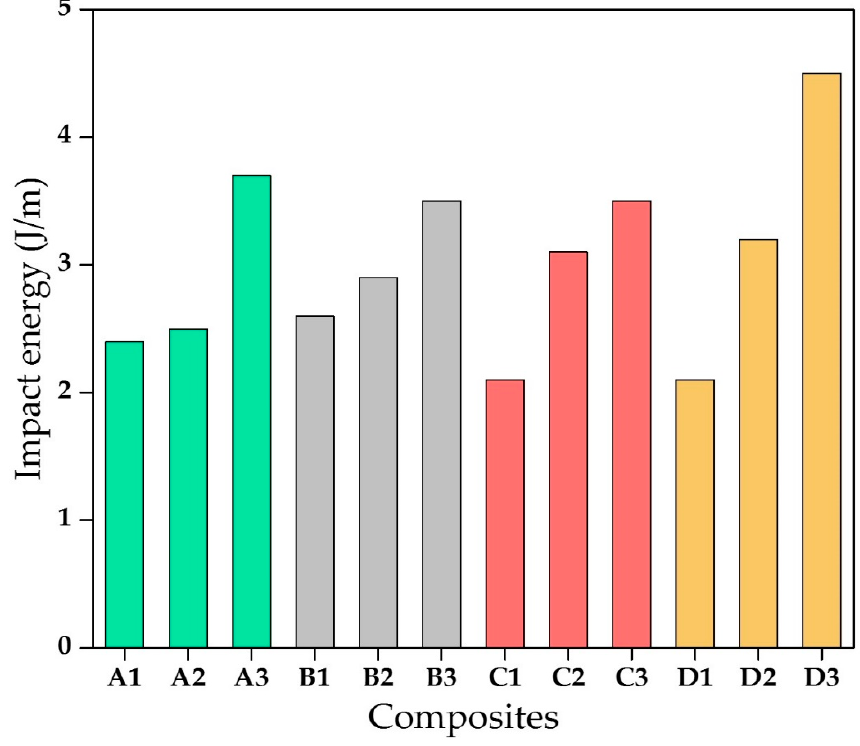
Figure 6. Impact behaviour of composites.